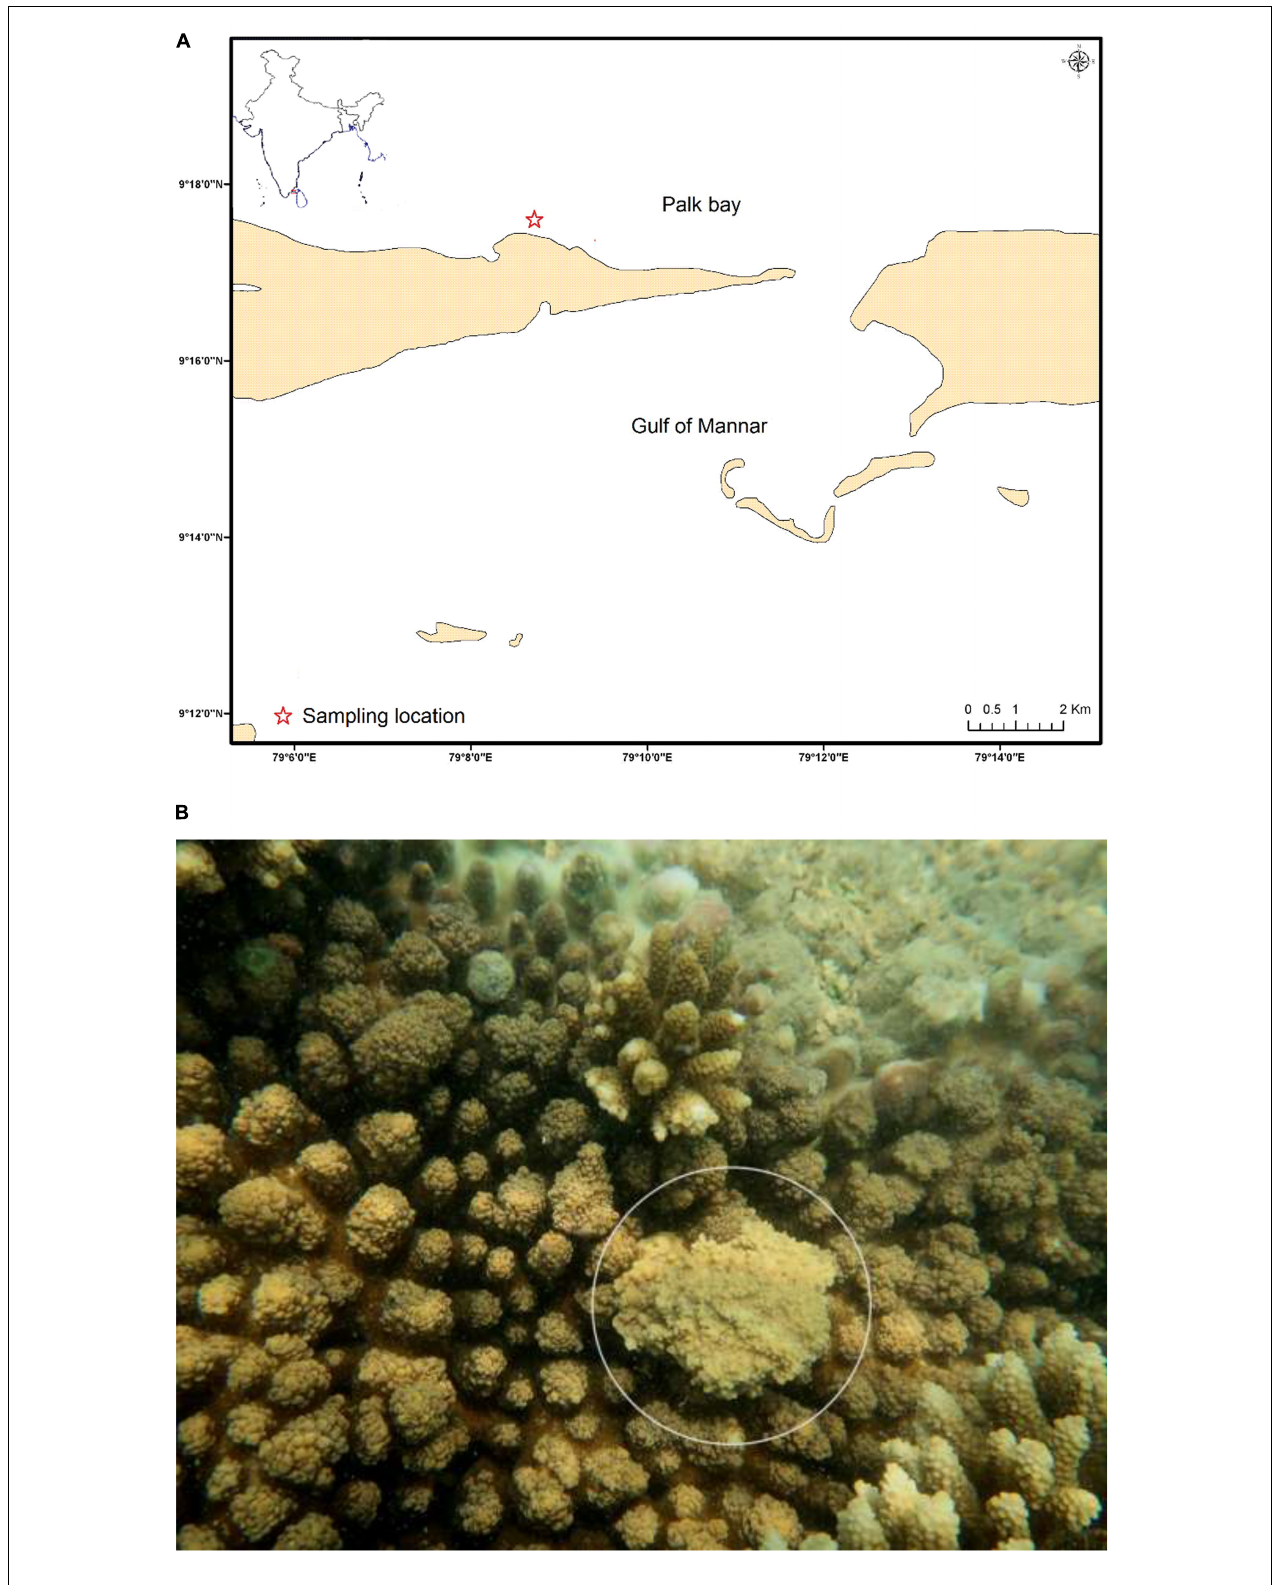
FIGURE 1 | (A) Sampling location of the Palk Bay coral reef ecosystem, Southeast coast of India (Asterisk indicates the sampling site); (B) Reef coral Acropora cytherea (white circle indicates the SGA).